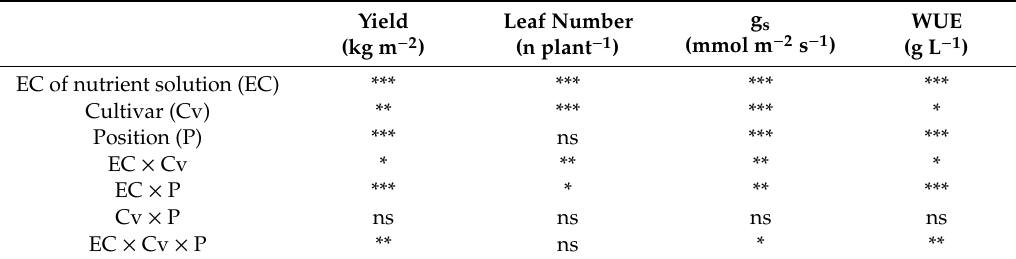
Table 5. Results from the ANOVA on experiment 4 (CDZ-Myanmar). E ff ect of EC of the nutrient solution (EC), cultivar (Cv), and position within the garden (P) on lettuce yield, leaf number, and water use e ffi ciency (WUE). Significant di ff erences at p ≤ 0.05 (*), p ≤ 0.01 (**) and p ≤ 0.001 (***), ns = not significant di ff